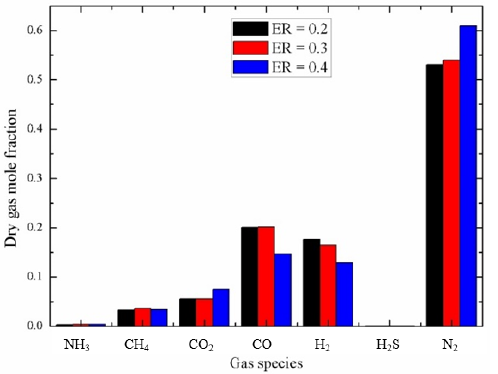
Figure 8. Molar concentrations of syngas components at different ERs (1050